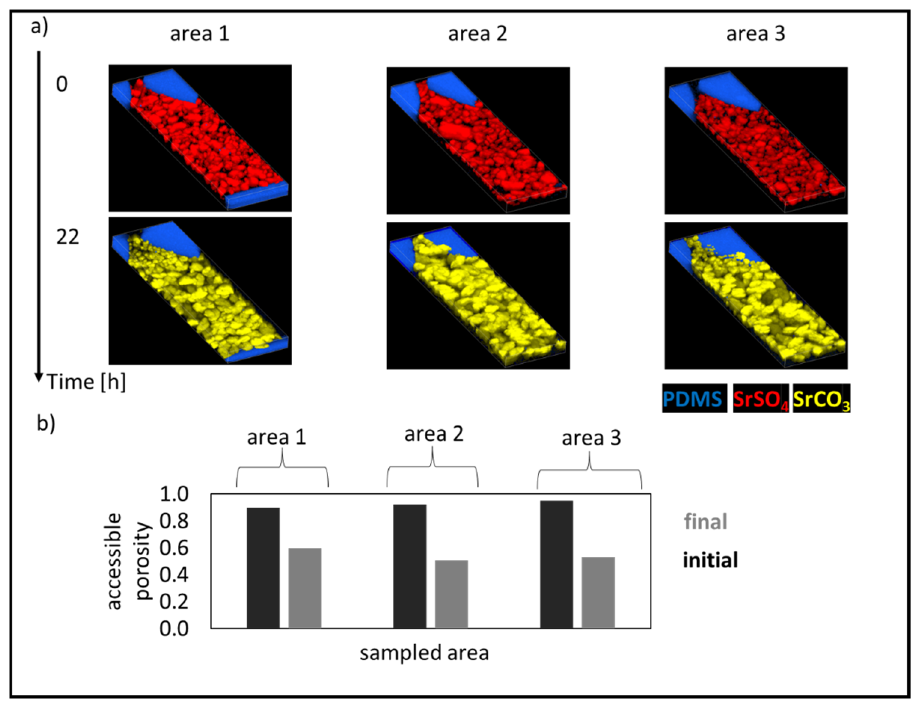
Figure 5. ( a ) Initial and final Raman tomographs of the sampled areas, and ( b ) the associated porosity